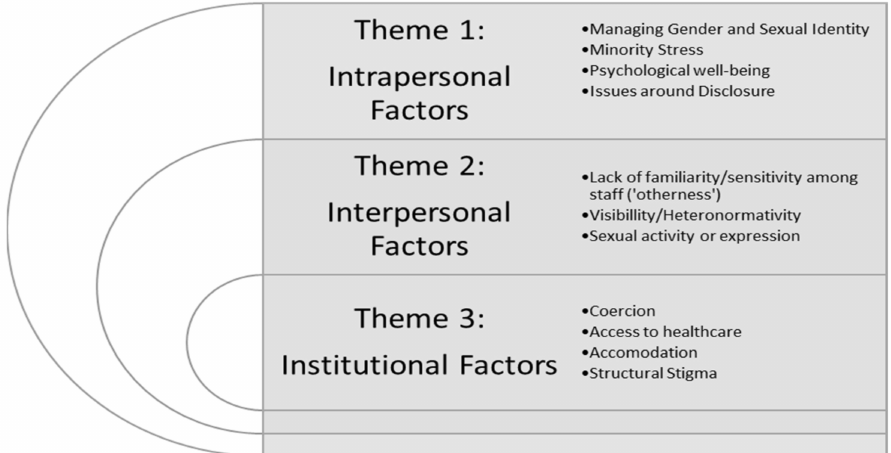
Figure 2. Thematic